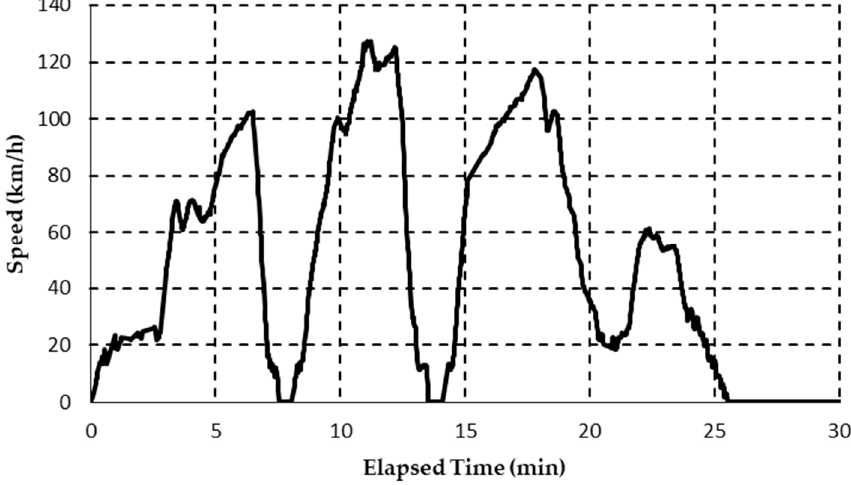
Figure 2. Union Pearson Express (UPE)-extracted reputable drive cycle.